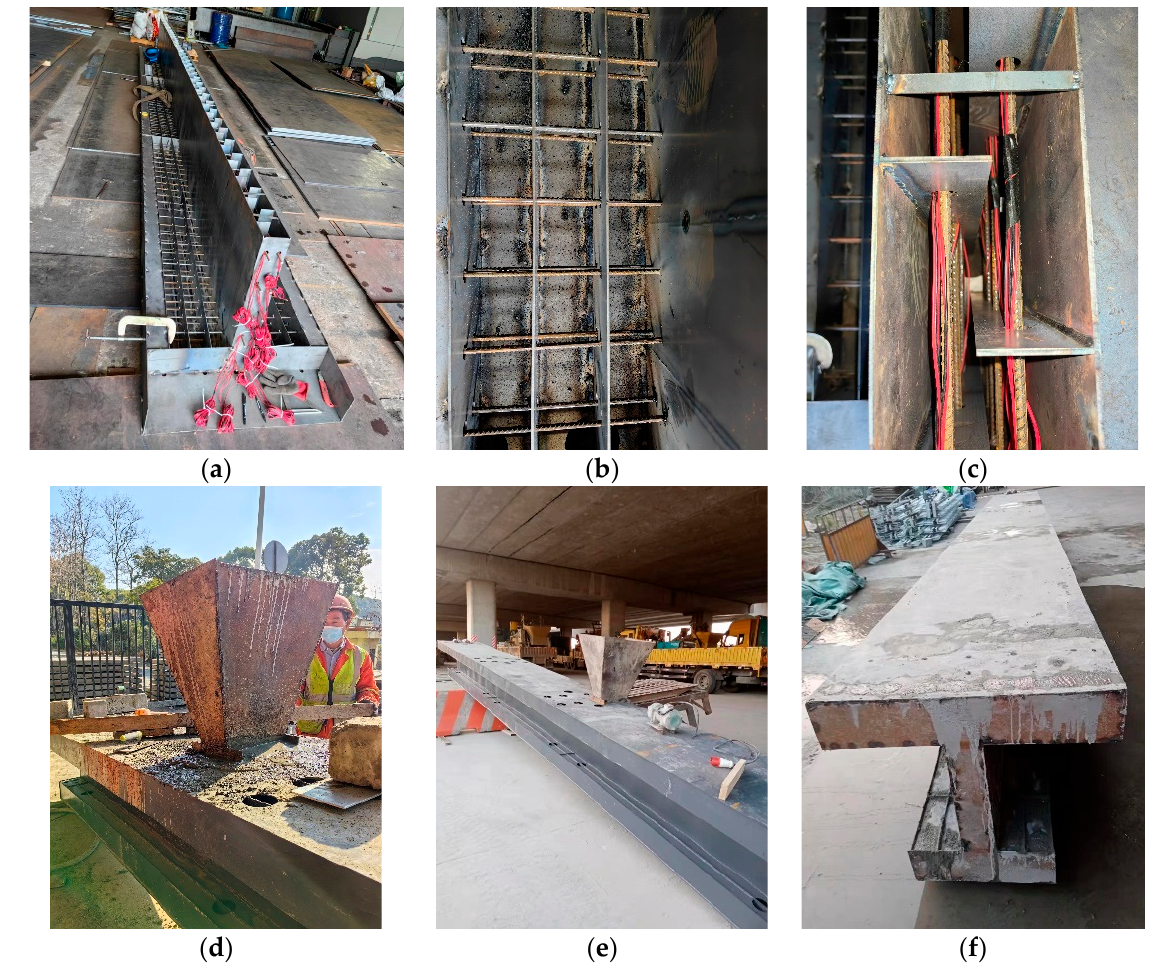
Figure 4. Photos during specimen construction. ( a ) Steel girder; ( b ) transversal reinforcing bars; ( c ) longitudinal reinforcing bars; ( d ) casting concrete; ( e ) vibrating concrete; and ( f ) fabricated specimen.